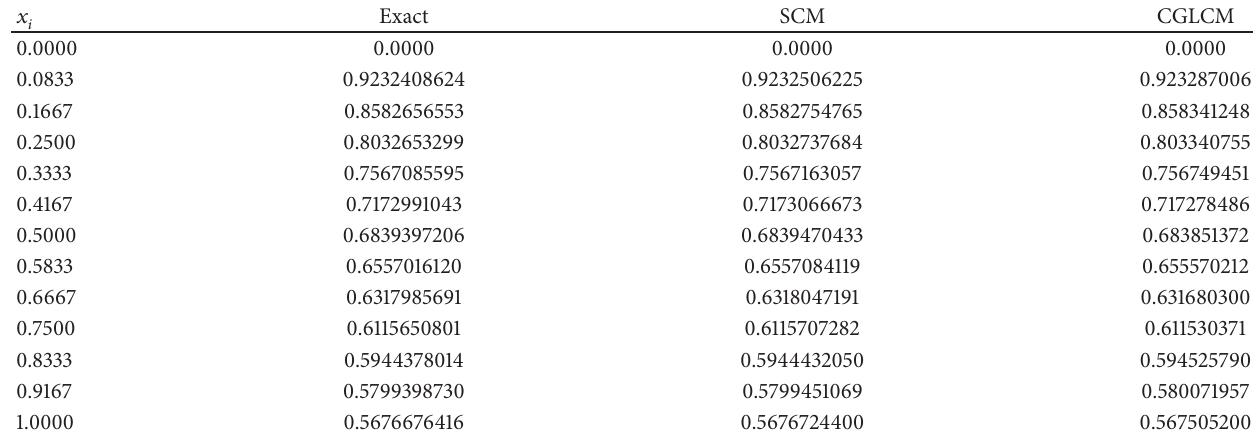
Table 3: Comparison of exact solution with numerical solution for Problem 2.